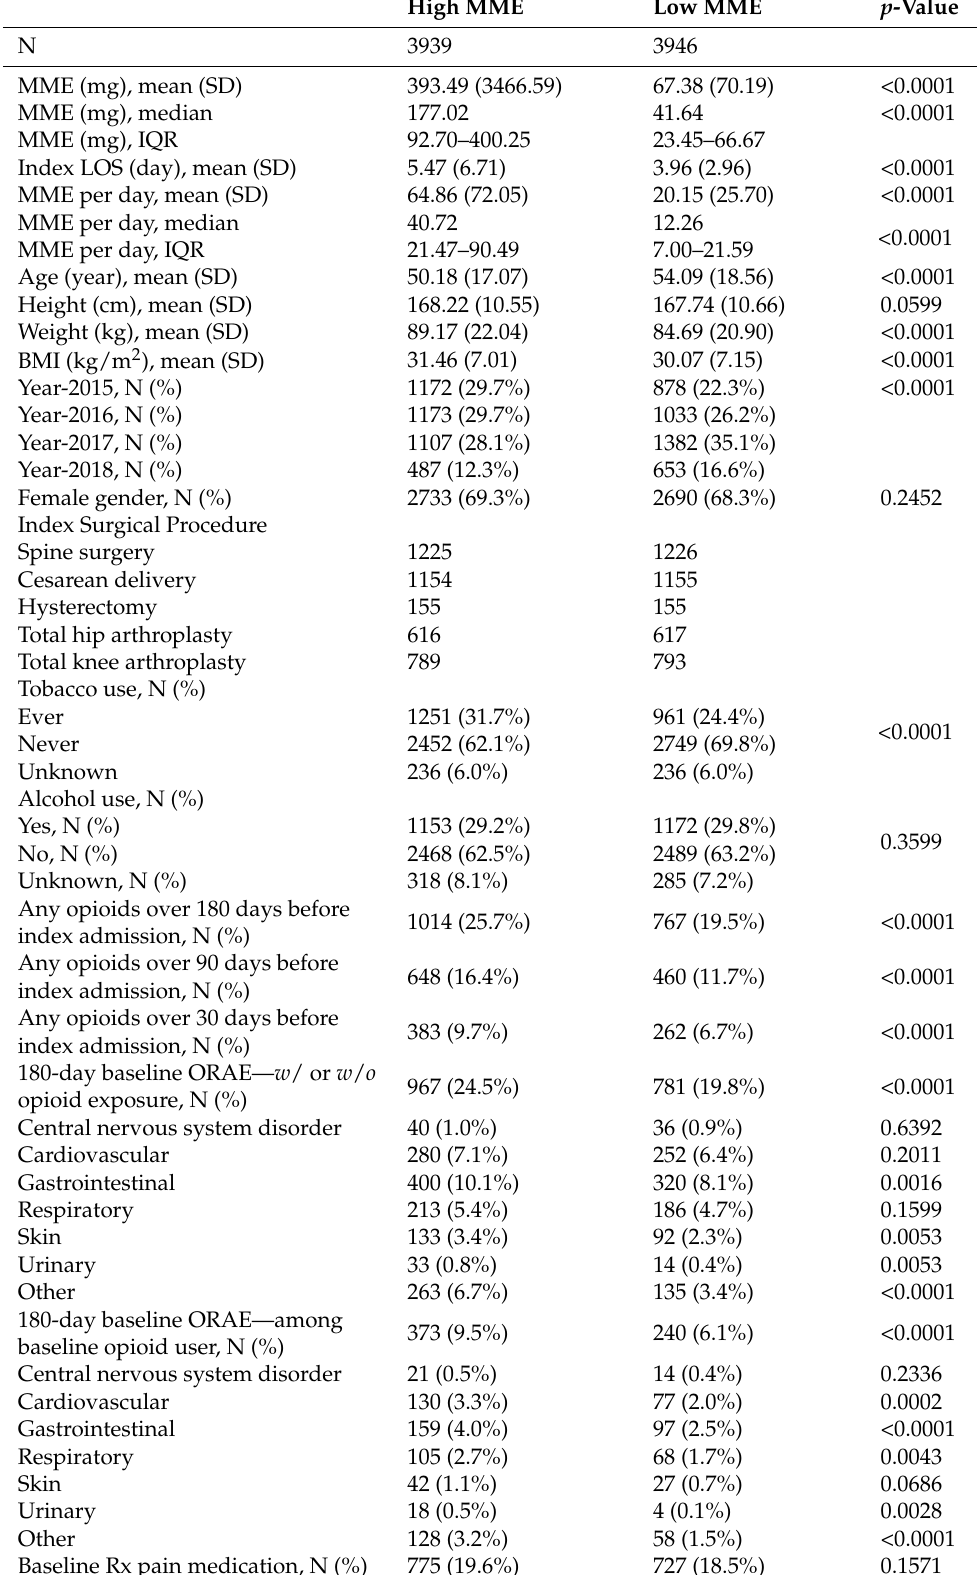
Table 1. Patient characteristics during the baseline (180 days before the index admission if not specified elsewhere) and index admission: high vs. low inpatient opioid